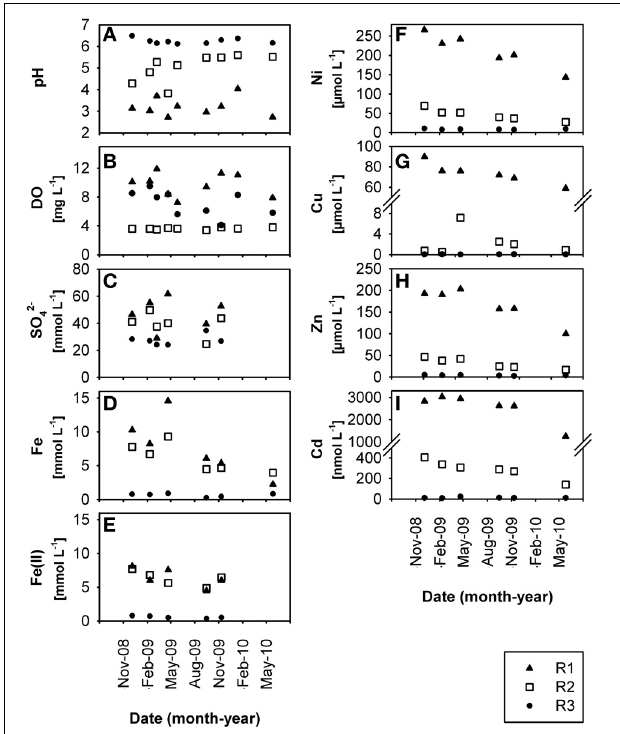
FIGURE 1 | Time-resolved chemical data for creek water: (A) pH, (B) dissolved oxygen, DO, (C) dissolved sulfate, SO 2 − 4 , (D) dissolved total Fe, (E) dissolved HCl-extractable Fe(II), (F) dissolved Ni, (G) dissolved Cu, (H) dissolved Zn, (I) dissolved Cd, at sites R1, R2, and R3 in the